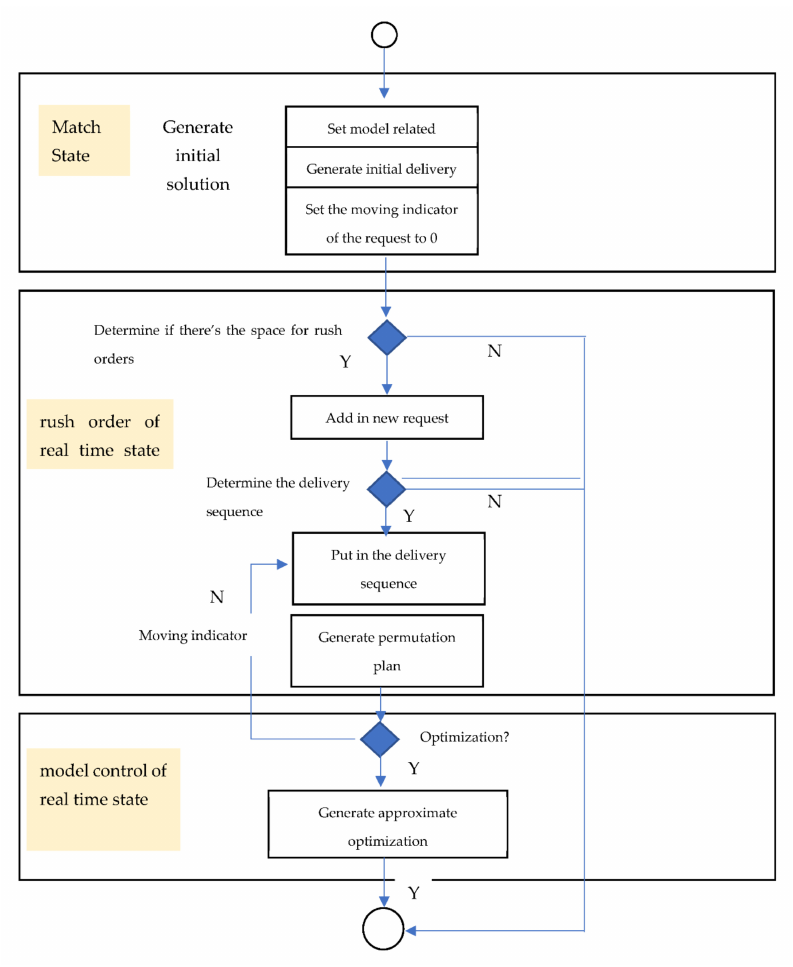
Figure 4. The process of the heuristic algorithm in this